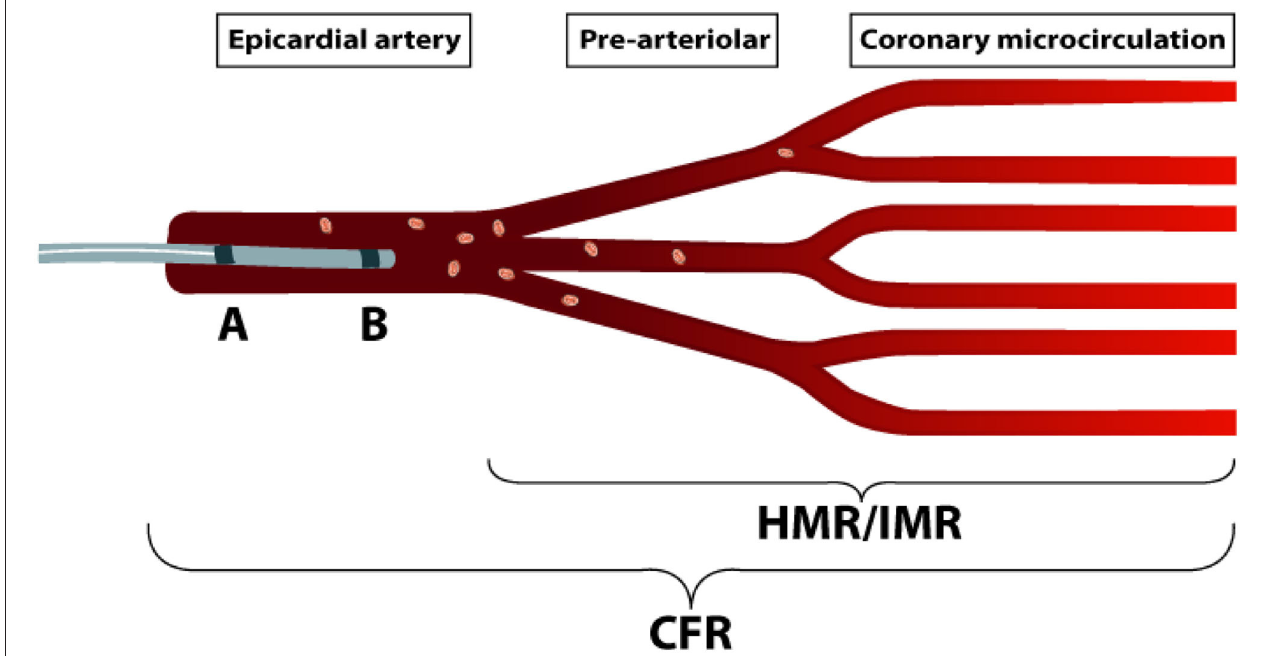
FIGURE 2 | Intracoronary function test. Schematic representation of the coronary circulation and different diagnostic techniques, showing measurements of CFR and microvascular resistance independent from the epicardial artery, with a ComboWire positioned in the LAD. The ComboWire consists of a Doppler-flow velocity sensor on the tip (B) , and a pressure-sensor more proximal (A) . Microvascular resistance can be measured using either HMR or IMR. HMR is a Doppler-based index, calculated as: Pd during hyperemia divided by the averaged peak flow velocity during hyperemia, and considered abnormal > 1.9. IMR is a bolus thermo-dilution based parameter, calculated as: Pd multiplied by the mean transit time during hyperemia, and considered abnormal > 25. LAD, left anterior descending coronary artery; CFR, Coronary flow reserve; HMR, Hyperemic microvascular resistance; IMR, Index of microcirculatory resistance; Pd, mean distal coronary pressure.